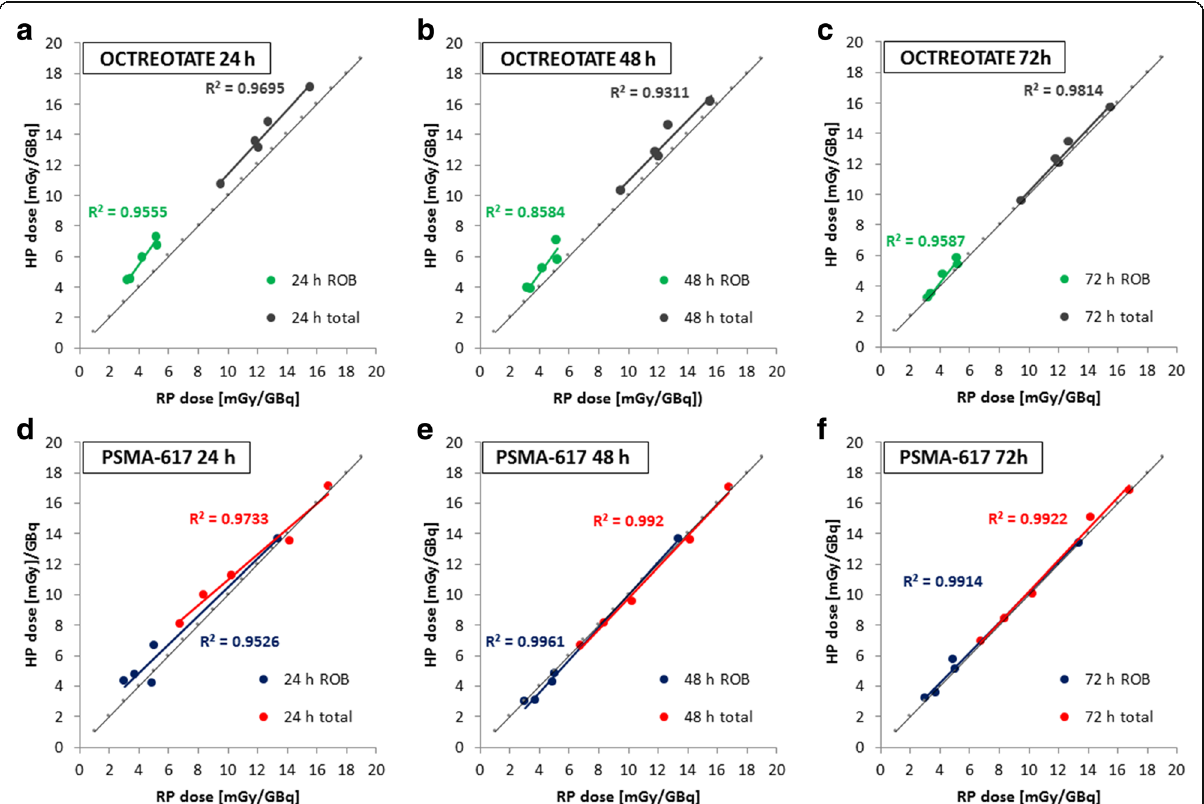
Fig. 5 Comparison of bone marrow absorbed doses from the ROB and total bone marrow absorbed doses as calculated via the reference protocol and the HP24, HP48, and HP72 (24, 48, or 72 h p.